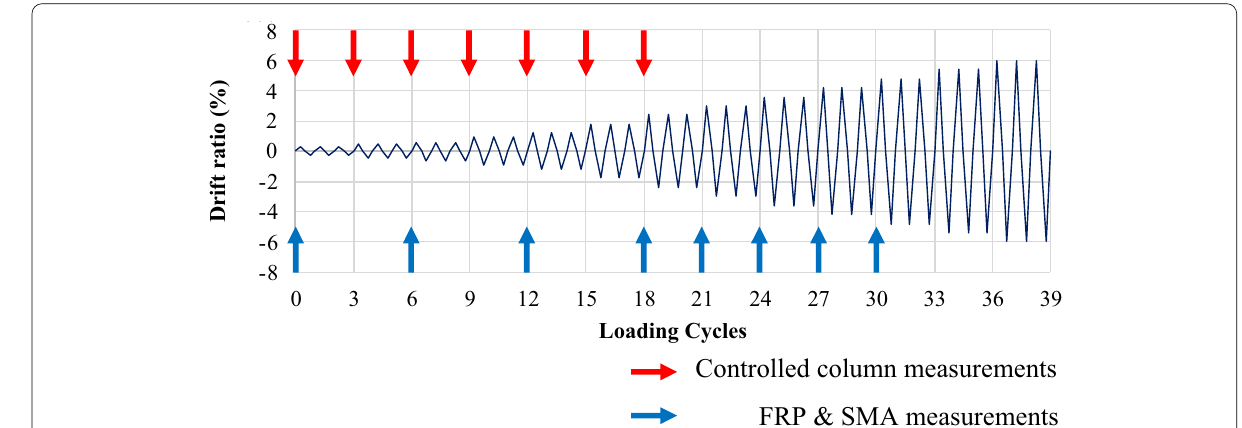
Fig. 7 Loading protocols with UPV measurement plan